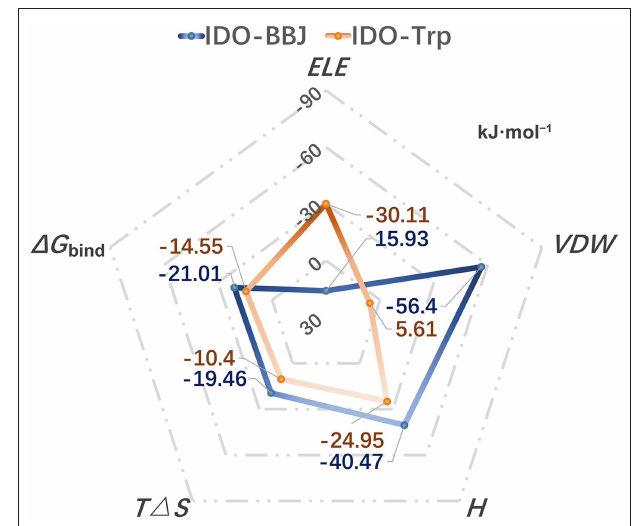
FIGURE 6 | Calculated binding free energies in the IDO-Trp and IDO-BBJ systems, as well as the main driving force for the formation of complexes.